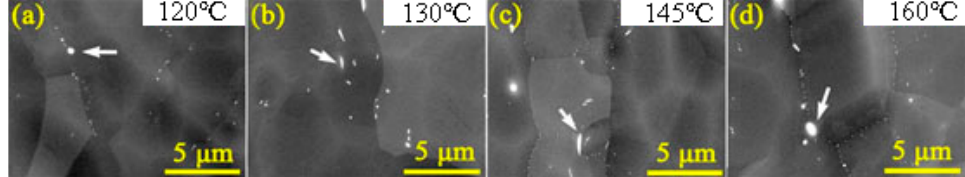
Figure 9. SEM images of Peak aging microstructure at different aging temperatures. ( a ) 120 °C; ( b ) 130 °C; ( c ) 145 °C; (d) 160 °C.